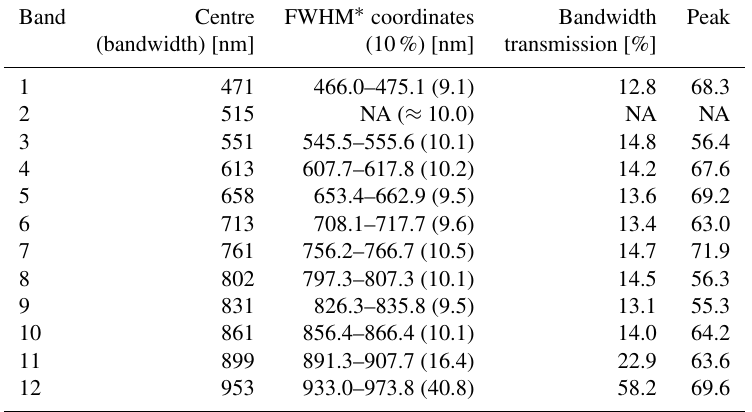
Table A1. Filter configuration of the Mini-MCA 12 and optical properties of the mounted filters. For band 2 (b) no fact sheet has been